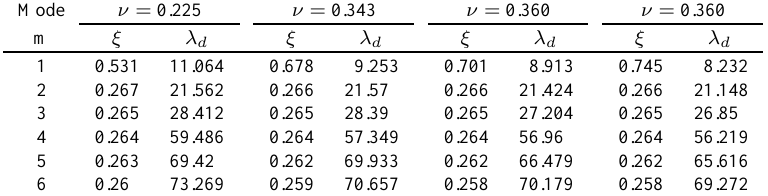
Table 2 Dimensionless damping ratios and damped frequency parameters λ dmn for different